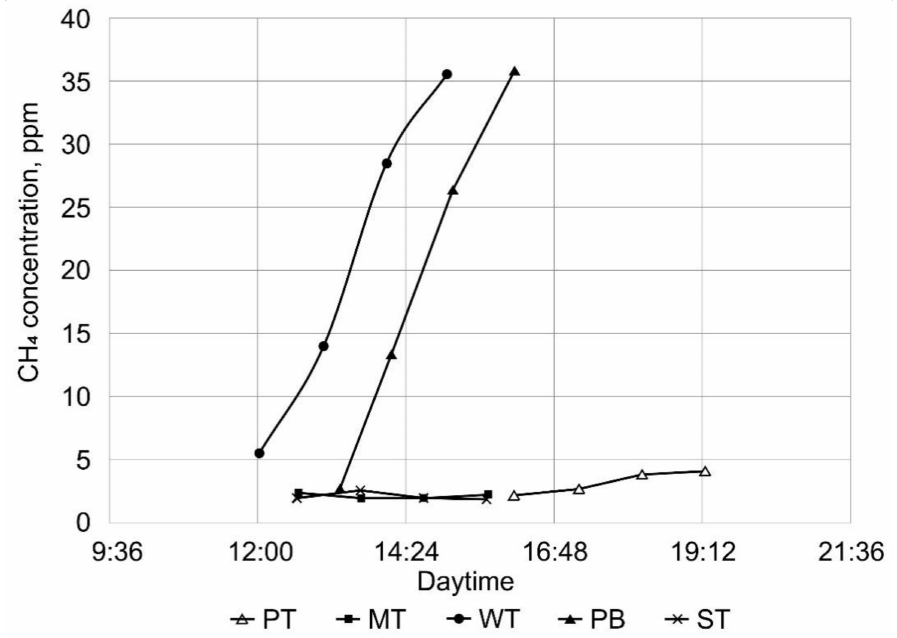
Figure 9. Graphs of methane accumulation in static chambers in the dominant landscapes of the Marre-Sale area (data for 20 August